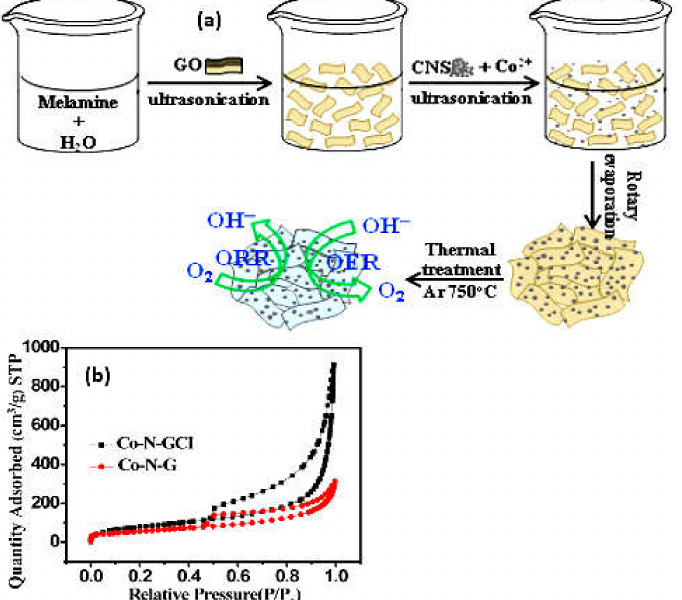
Figure 2. ( a ) Schematic illustration of the fabrication process for the Co-N-G catalyst along with effective catalytic performance towards OER and ( b ) nitrogenadsorption/desorption isotherms. Copyright 2016 by the American Chemical Society